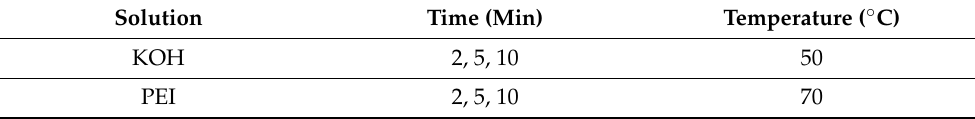
Table 2. Time variations for the wet chemistry